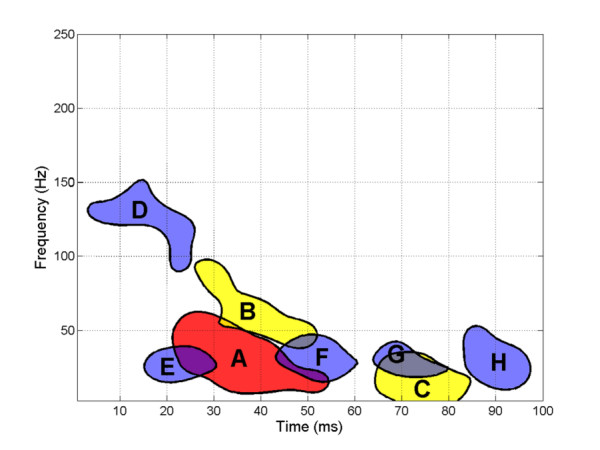
Distribution of latency and frequency of stable SEP t-f components. Based on their relative energy, the seven stable t-f components are distinguished by color. Red color denotes the high-energy t-f components, yellow denotes the middle-energy t-f components, and blue denotes the low-energy t-f components.